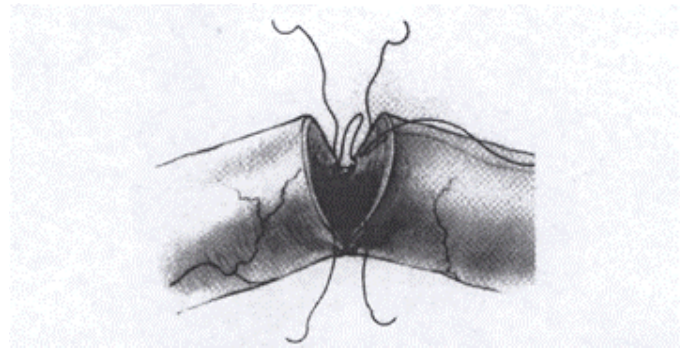
FIGURE 7 . Posterior row has been completed. The vas-holding clamp has been turned, and three 10-0 luminal sutures are placed. One can use sutures with needles on either end, as shown in the illustration, or cut the sutures in half. It is easier to leave the last two or three sutures unties until they are all placed.